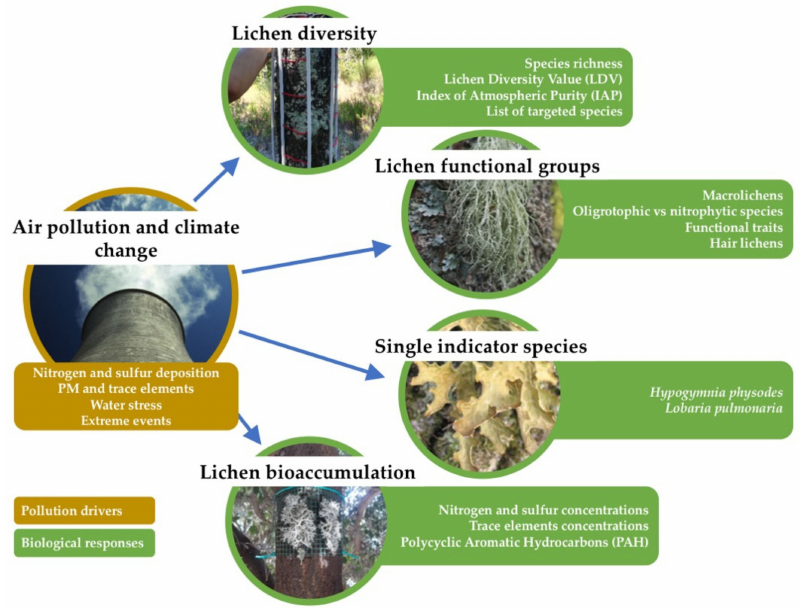
Figure 1. Conceptual diagram describing the relations between the main pollution drivers and the methodological approaches based on lichen responses adopted in forest ecosystems. Photos: air pollution and climate change (cooling tower of a geothermal power plant); lichen diversity (sampling grid for lichen diversity value monitoring [17]); lichen functional groups (the fruticose lichen Ramalina farinacea ); single indicator species (the air pollution-sensitive foliose species Lobaria pulmonaria ); bioaccumulation (samples of the foliose lichen Pseudevernia furfuracea exposed on a tree during a bioaccumulation survey). Photos by Giorgio